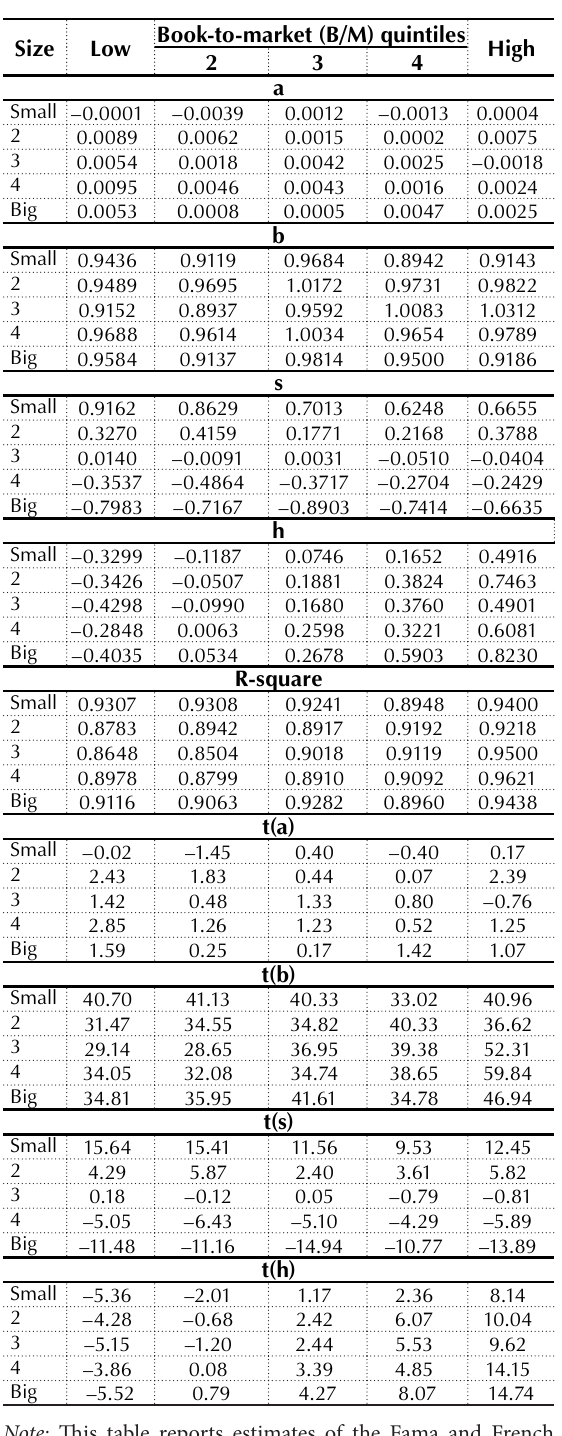
Table 4. Fama-French three-factor model regressions over the period